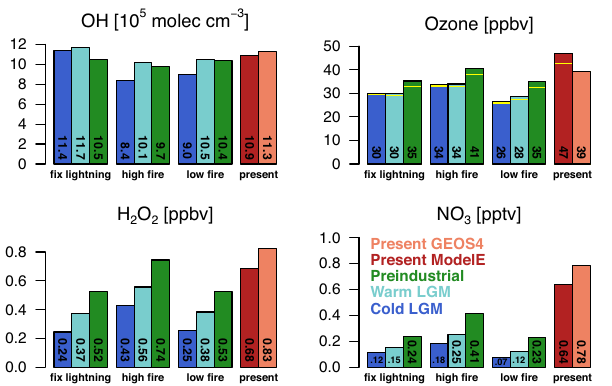
Fig.9. GlobalannuallyaveragedchemicalproductionandlossratesofOHineachsimulation,bycontributingreaction.Thenumbersalong Fig. 9. Global annually averaged chemical production and loss Fig. 8. Tropospheric mean mass-weighted oxidant burdens, calcu- thebottomaretroposphericairmass-weightedmeanOH( 10 5 moleculescm (cid:0) 3 ). Fig. 8. Tropospheric mean mass-weighted oxidant burdens, calculated with the tropopause determined from the thermal lapse rate. For rates of OH in each simulation by contributing reaction. The num- comparisonwithACCMIP(Youngetal.,2013),thehorizontalyellowlinesforozoneshowthetroposphericburdencalculatedusinga150 lated with the tropopause determined from the thermal lapse rate. ppbchemicaltropopause. bers along the bottom are tropospheric air-mass-weighted mean OH For comparison with ACCMIP (Young et al., 2013), the horizon- (10 5 moleculescm − 3 tal yellow lines for ozone show the tropospheric burden calculated using a 150ppb chemical tropopause.